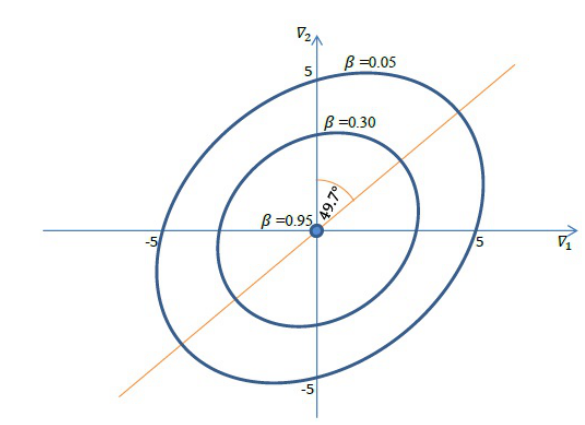
Figure 1: Probability of type 2 decision error function β ( ∇ 1 , ∇ 2 ) in Eq. 35 for the straight line fit example in section